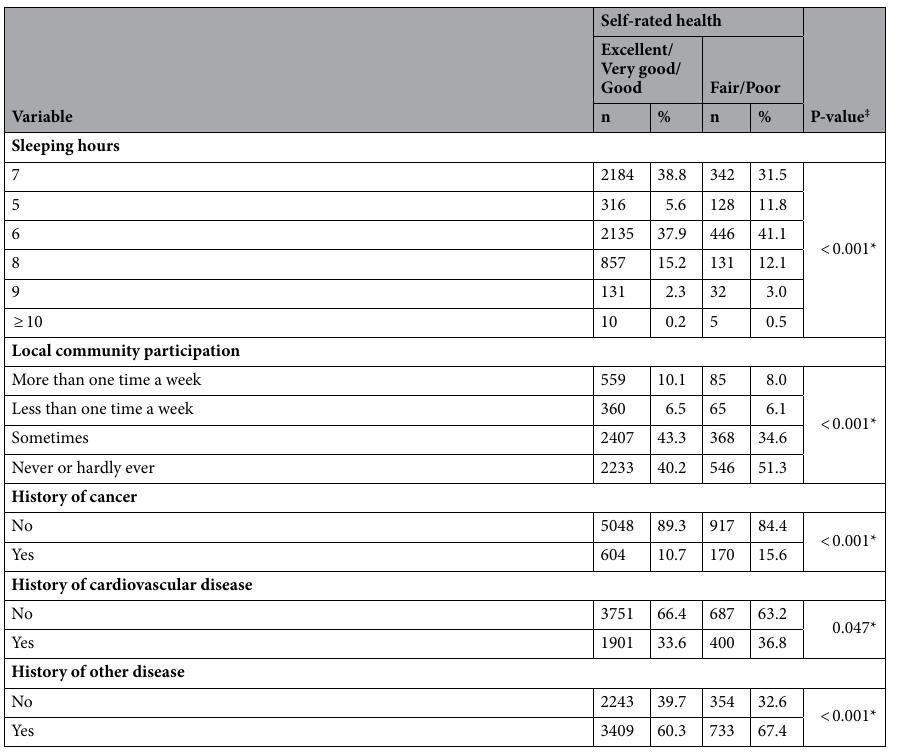
Table 1. Characteristics of subjects. BMI body mass index. ‡ p-value based on the chi-squared test. *Statistically significant (p <